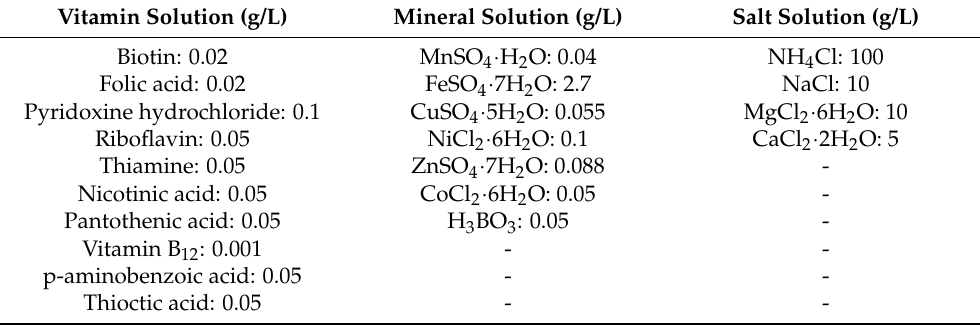
Table 2. The content of the nutrient base media used to support the growth of the homoacetogenic